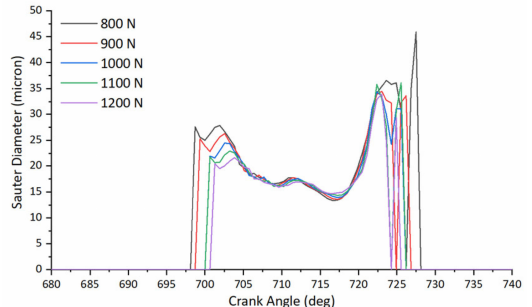
Figure 19. Fuel SMD under varied needle valve opening pressures.